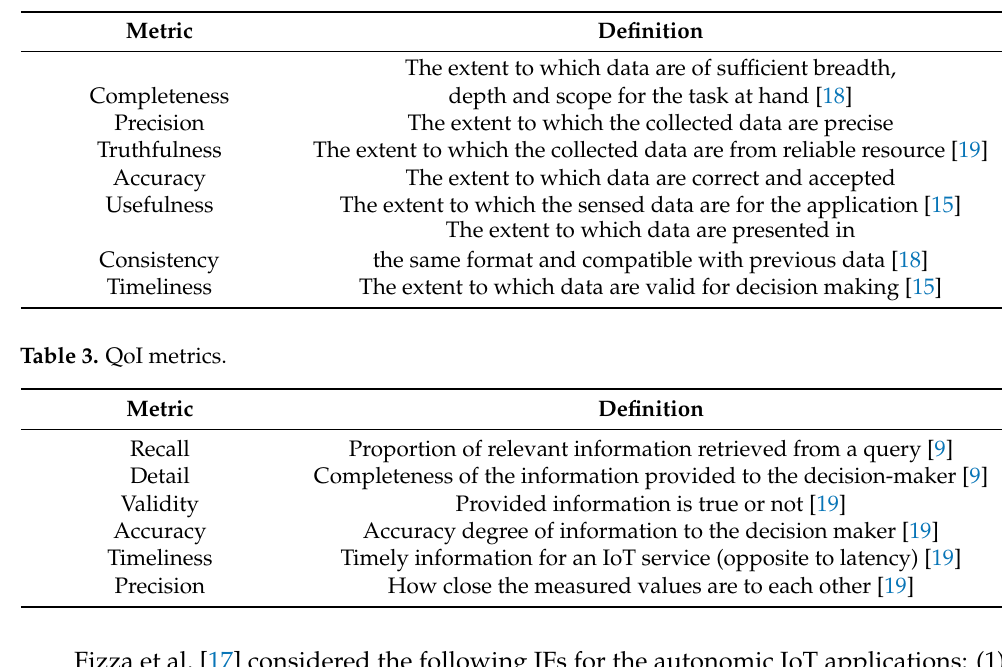
Table 2. QoD metrics.